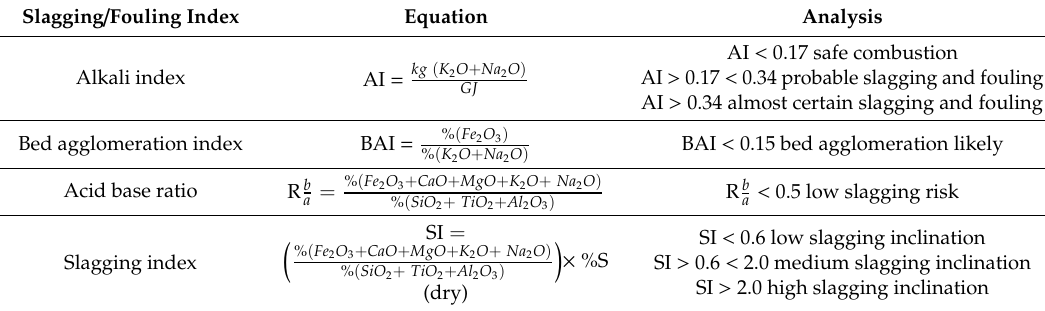
Table 1. Predictive slagging and fouling